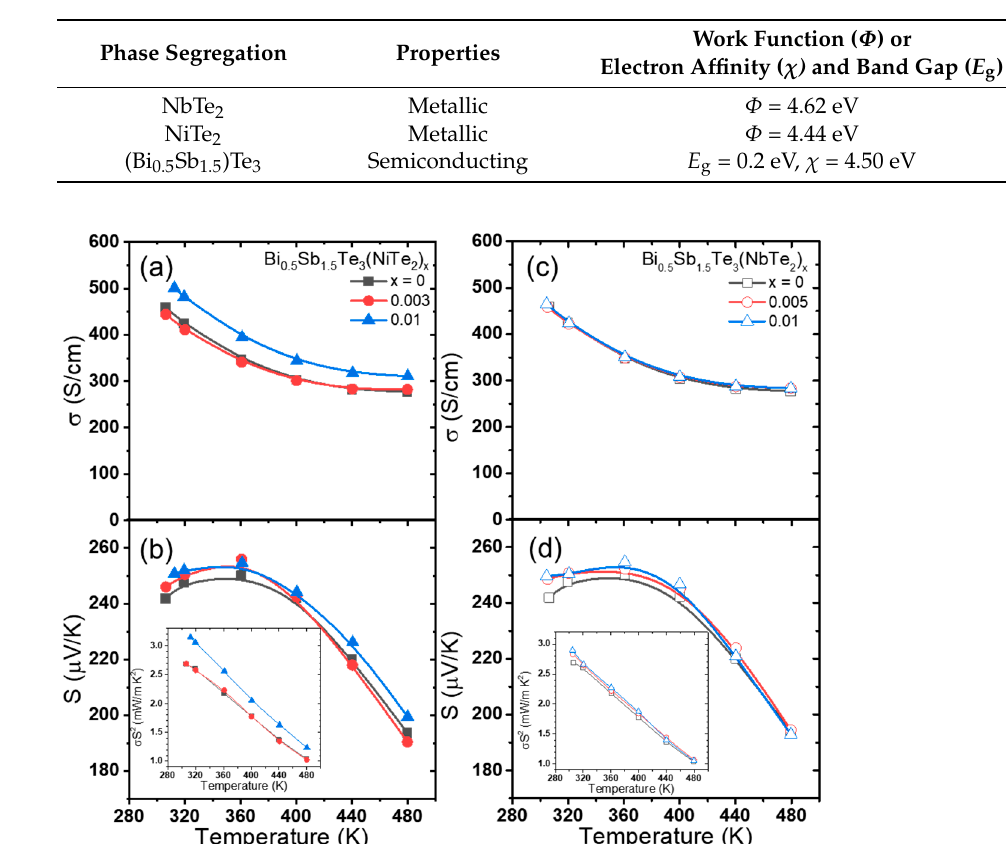
Figure 3. Temperature dependence of ( a , c ) the electrical conductivity and ( b , d ) the Seebeck coefficient for Bi 0.5 Sb 1.5 Te 3 (NiTe 2 ) x ( x = 0, 0.003, 0.01) and Bi 0.5 Sb 1.5 Te 3 (NbTe 2 ) x ( x = 0, 0.005, 0.01). Inset graphs in ( b , d ) exhibit the power factors of the samples.